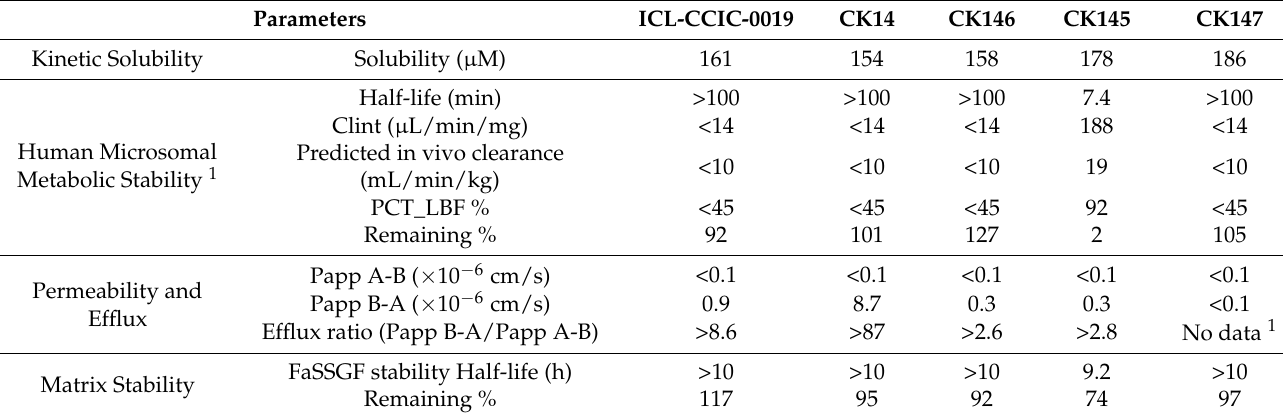
Table 1. Pharmacokinetic parameters of ICL-CCIC-0019, CK14, CK145, CK146 and CK147 from four ADME assays: kinetic solubility, human microsomal metabolic stability, permeability and efflux, and matrix stability.